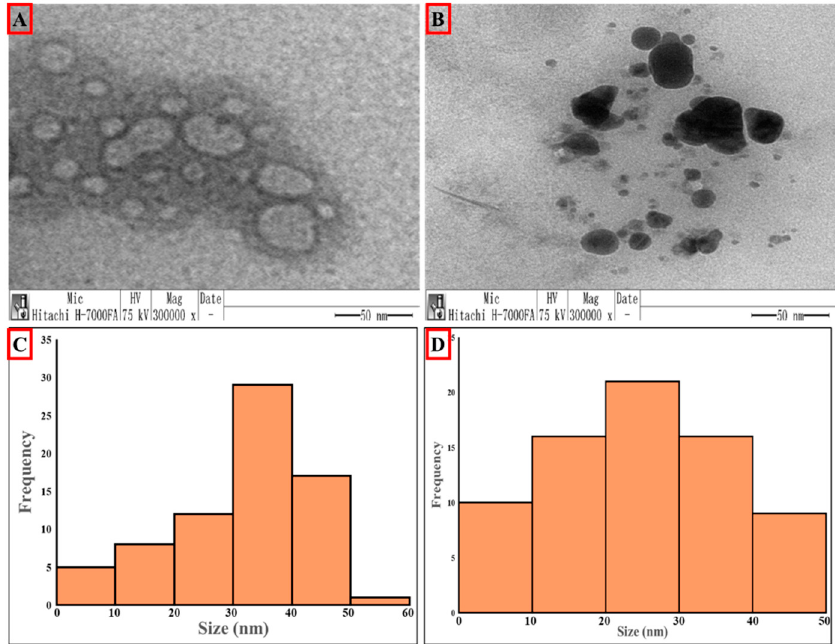
Figure 6. TEM images and particle size distribution of the synthesized AgNPs; ( A ) MS-AgNPs structure, ( B ) bare AgNPs structure, ( C ) MS-AgNP particle size distribution, ( D ) bare AgNP particle size distribution.